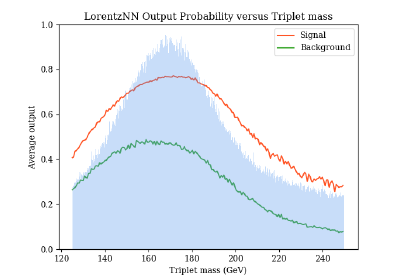
Figure 9. Average LNN output plotted against triplet mass. Performance is most increased in high energy tail of mass